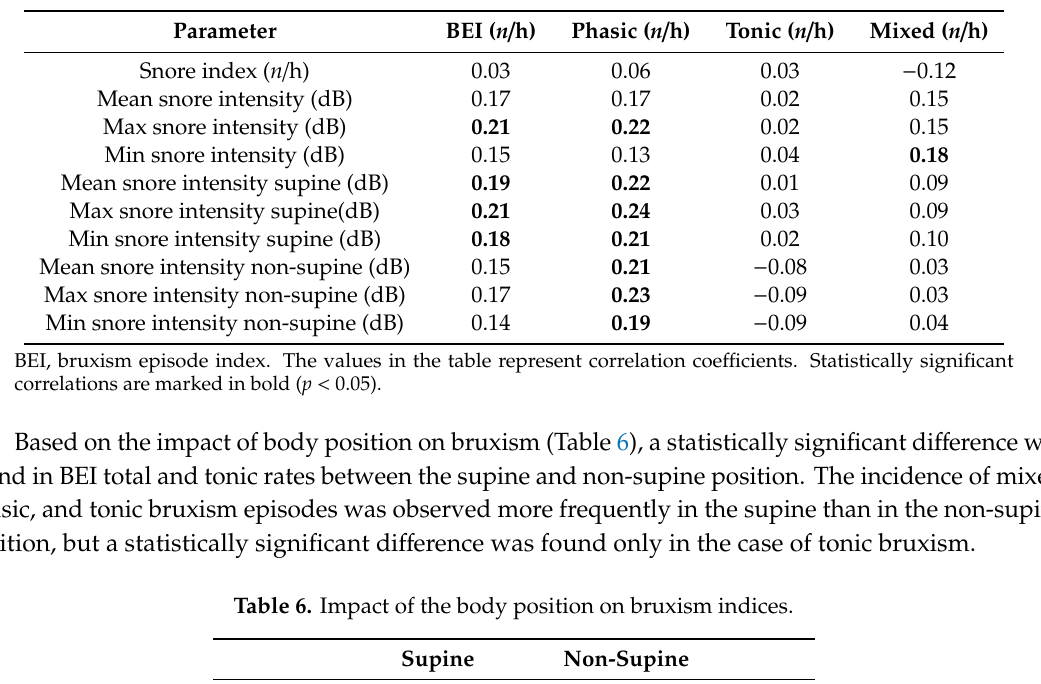
Table 5. Correlation between snore intensity parameters and bruxism episode index.